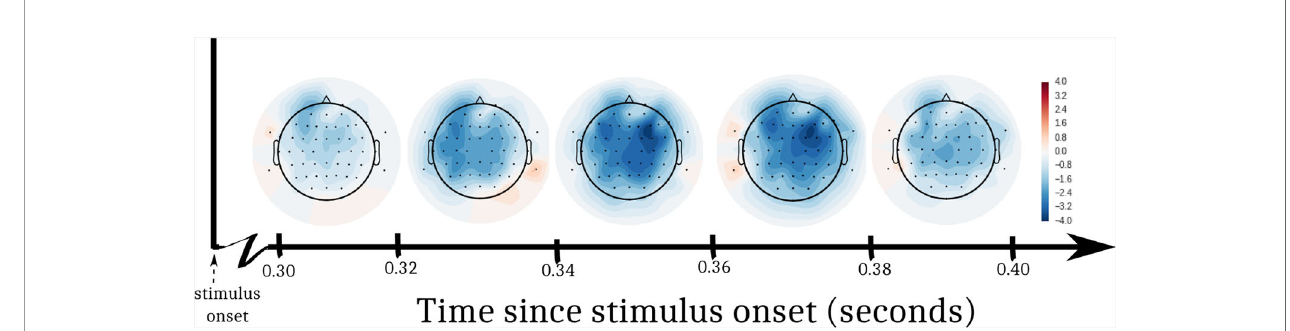
FIGURE 3 | T-statistics from EEG analysis. We performed an ANOVA at each electrode to predict EEG voltage. Log trial number and DBS status (ON, OFF) were factors. The interaction of the factors was a signi fi cant predictor of EEG voltage in the left and right frontal quadrants of the participant ’ s scalp. Swaths of color represent t-values from the ANOVA within 5 sub-windows of time after the stimulus